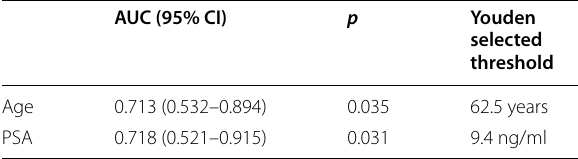
AUC area under the curve, CI confidence interval, PSA prostate specific